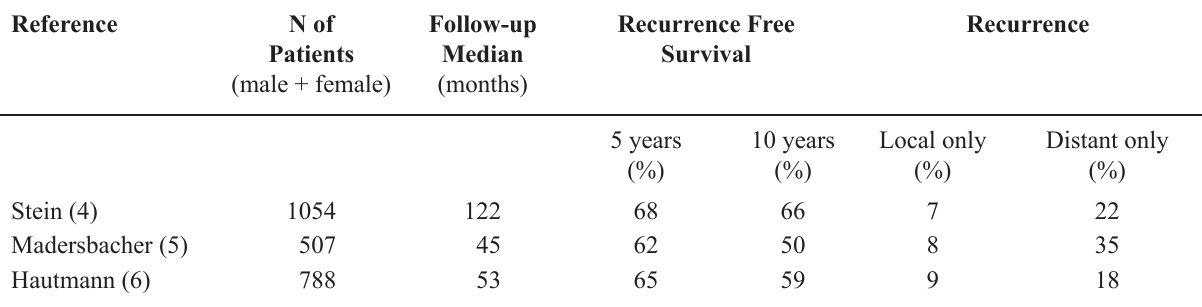
Table 1 – Largest single institution studies looking at recurrence free survival rates after cystectomy.